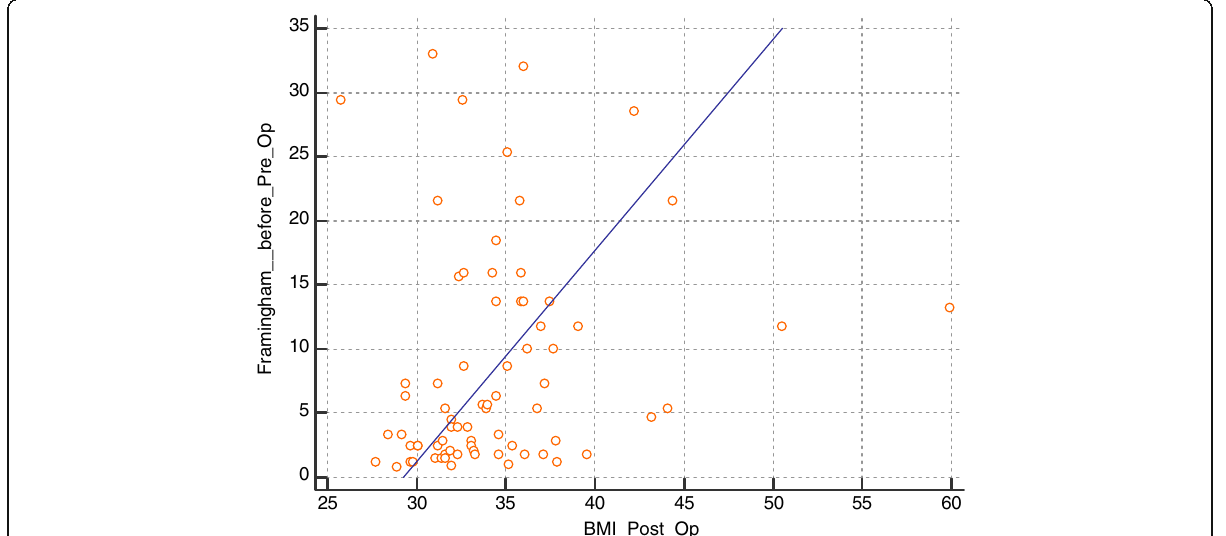
Fig 4 Correlation between postoperative BMI and preoperative Framingham